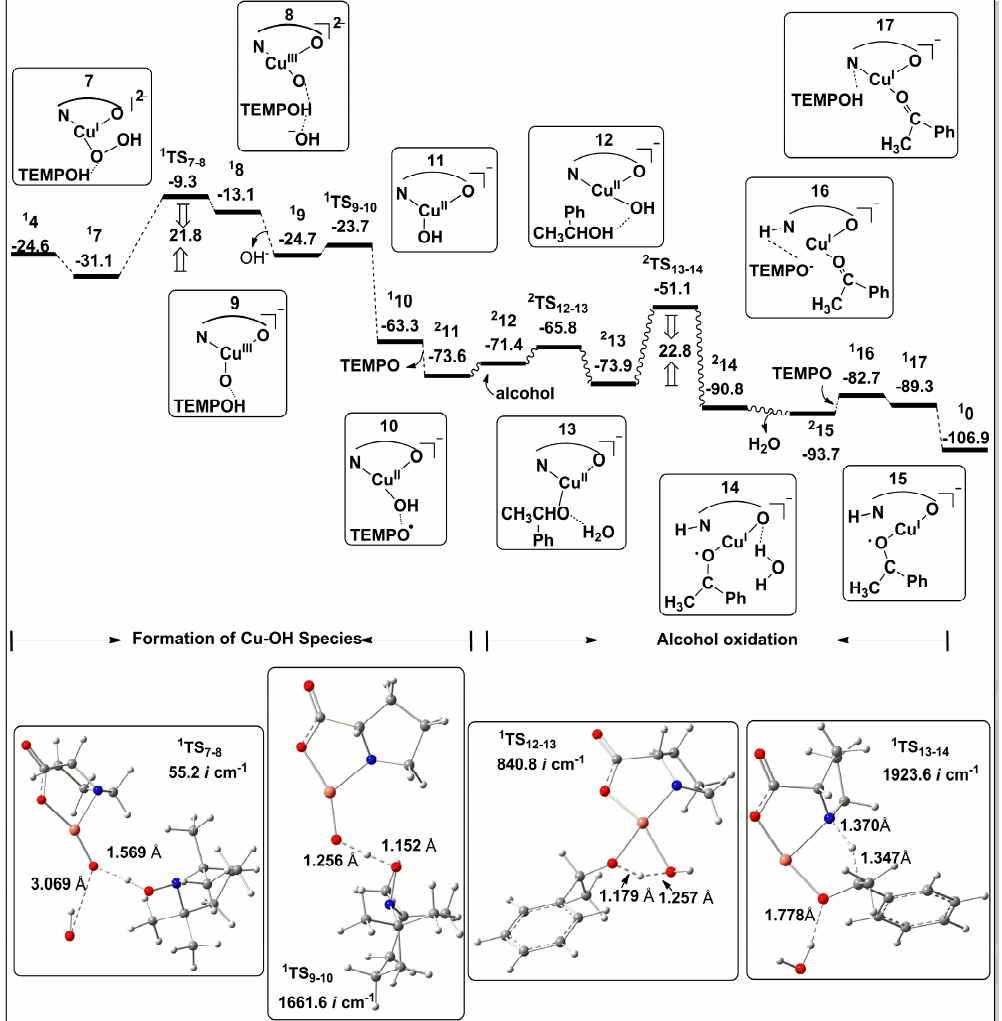
Figure 2. The calculated Gibbs free energy profiles for path B. The dashed line represents the singlet state; the wave line represents the doublet state. The energy values are in kcal/mol.